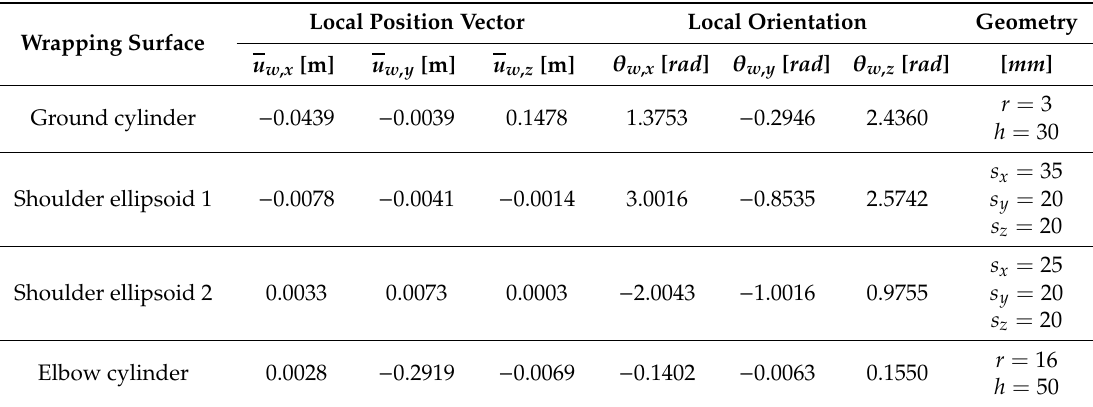
Table 6. Wrapping surfaces location and orientation with respect to the reference joints and